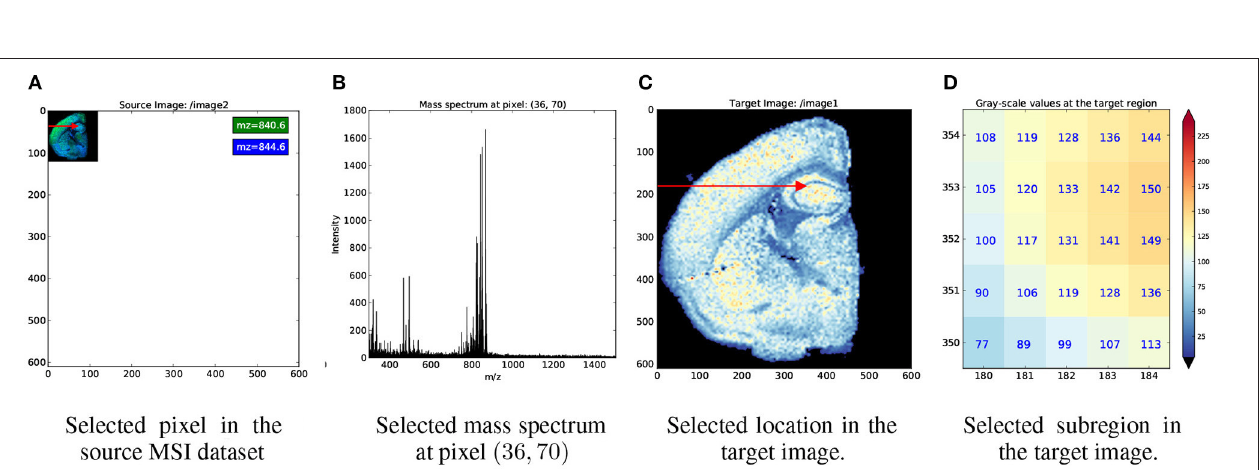
FIGURE 5 | Example showing the application of index map relationships for data selection. (A) First we apply the selection [36,70] (red arrow) to our source, MSI dataset. (B) As expected, this results in the selection of a single mass spectrum. (C) We next map the same selection to our target dataset. From the red arrow we can see that the selection was mapped correctly to same relative location as in our source, image. (D) The pixel plot illustrates that the mapping resulted, as expected, in the selection of a 5 × 5 sub-image from our target image. In (C,D) we use the color map shown on the right to map gray-scale values in the monochrome image to